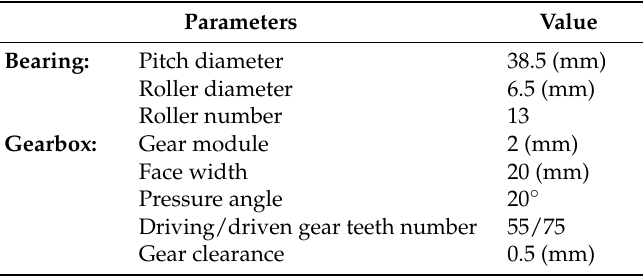
Figure 5. Fault diagnosis testbed of rotating machinery. Table 3. Parameters of bearing and gearbox.